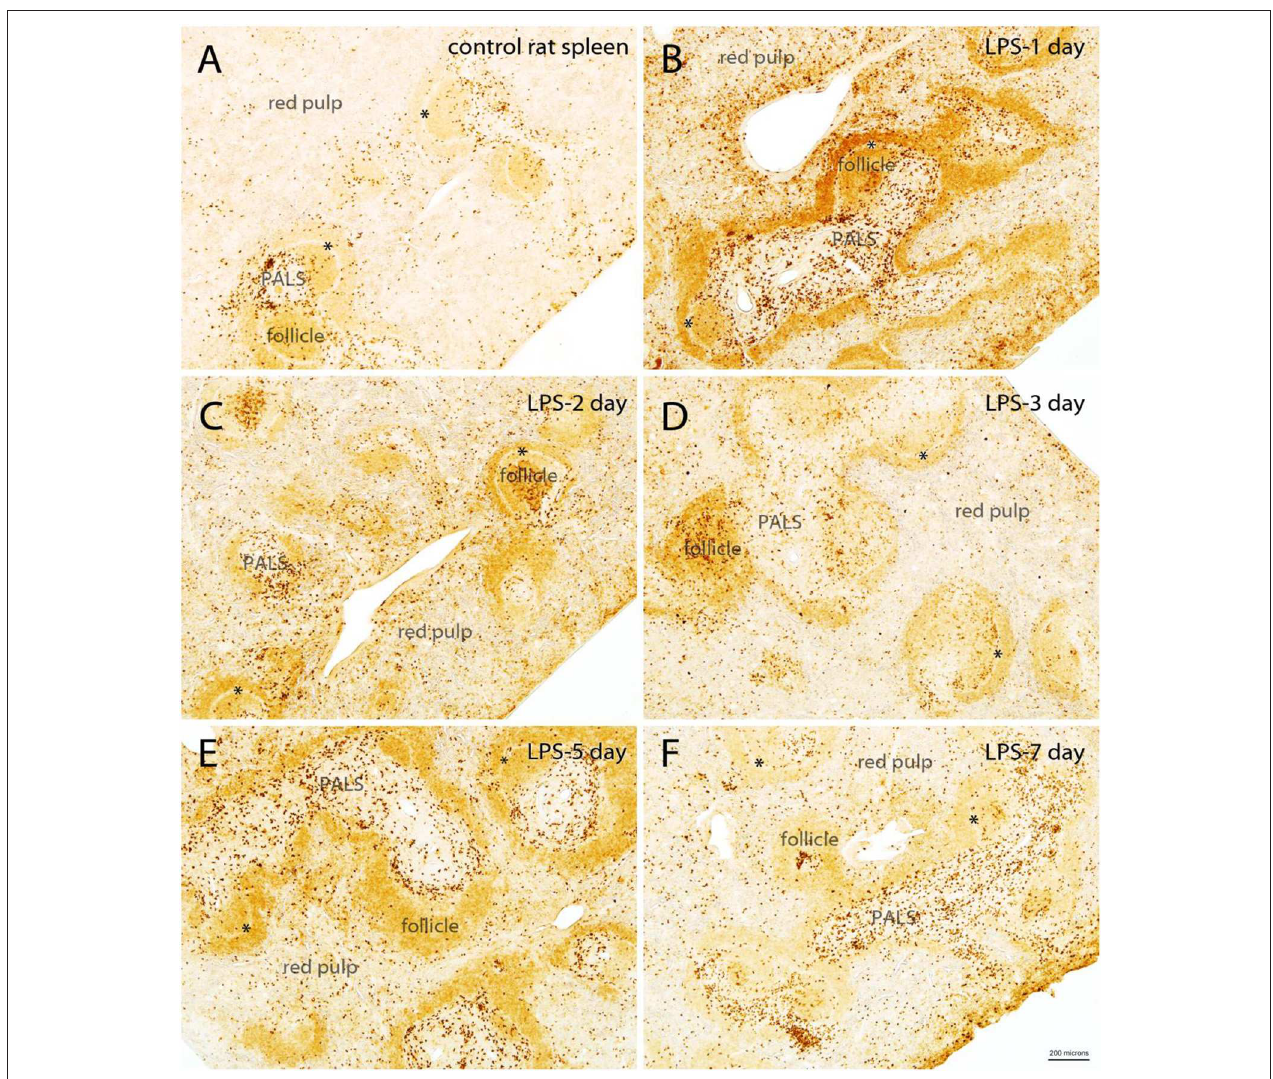
FIGURE 5 | Time course of Quin-IR in the rat spleen after intracerebral injection of LPS into the hippocampus (A–F) . Quin-IR was modest in the control rat spleen, but was substantially increased 1 day after injection of 4 µ g of LPS into the hippocampus. Strong increases in Quin-IR occurred in all compartments of the spleen (red pulp, PALS, and follicles). Quin-IR remained elevated, but slowly diminished, over the next several days. By day 7, the Quin-IR was returning to near-control levels, but remained elevated. *, marginal sinus. Bar in (F) , 200 µ m for all